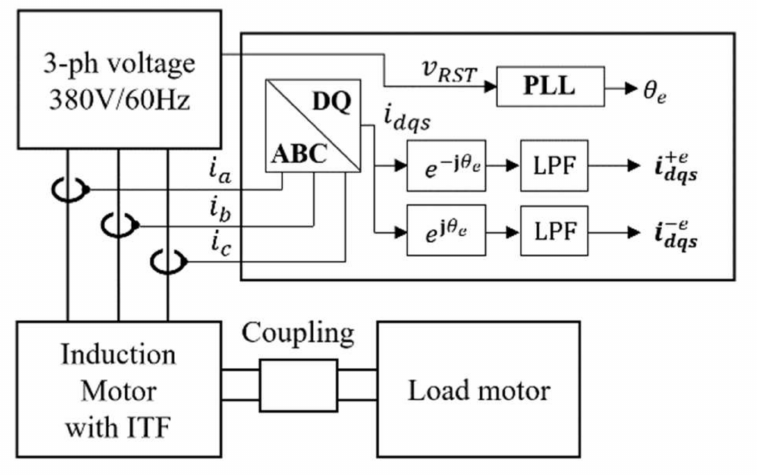
Figure 8. Extractor of positive and negative sequence